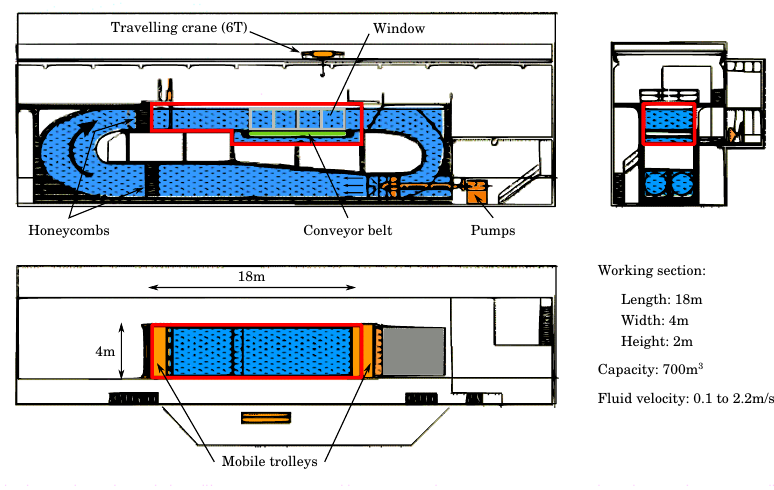
Figure 1. Side views ( top ) and top view ( bottom ) of the flume tank of I FREMER at Boulogne-sur-mer, France. Table 1. Testing facilities main characteristics. Note that the maximum velocity is limited in the flume tanks when including waves. The diameter of the F LO W AVE tank is 25 m according to schematic 3, but an equivalent usable length of 15 m is considered in the following